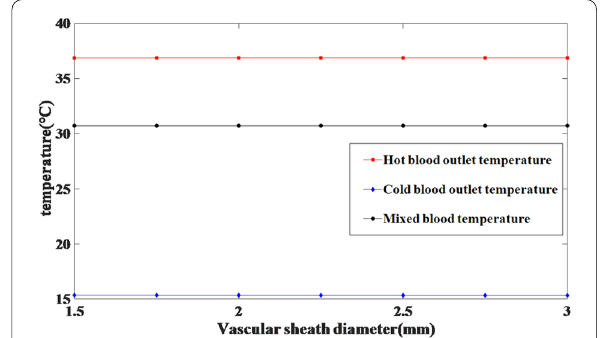
Figure 9 Output temperature trend curves influenced by vascular sheath length during countercurrent